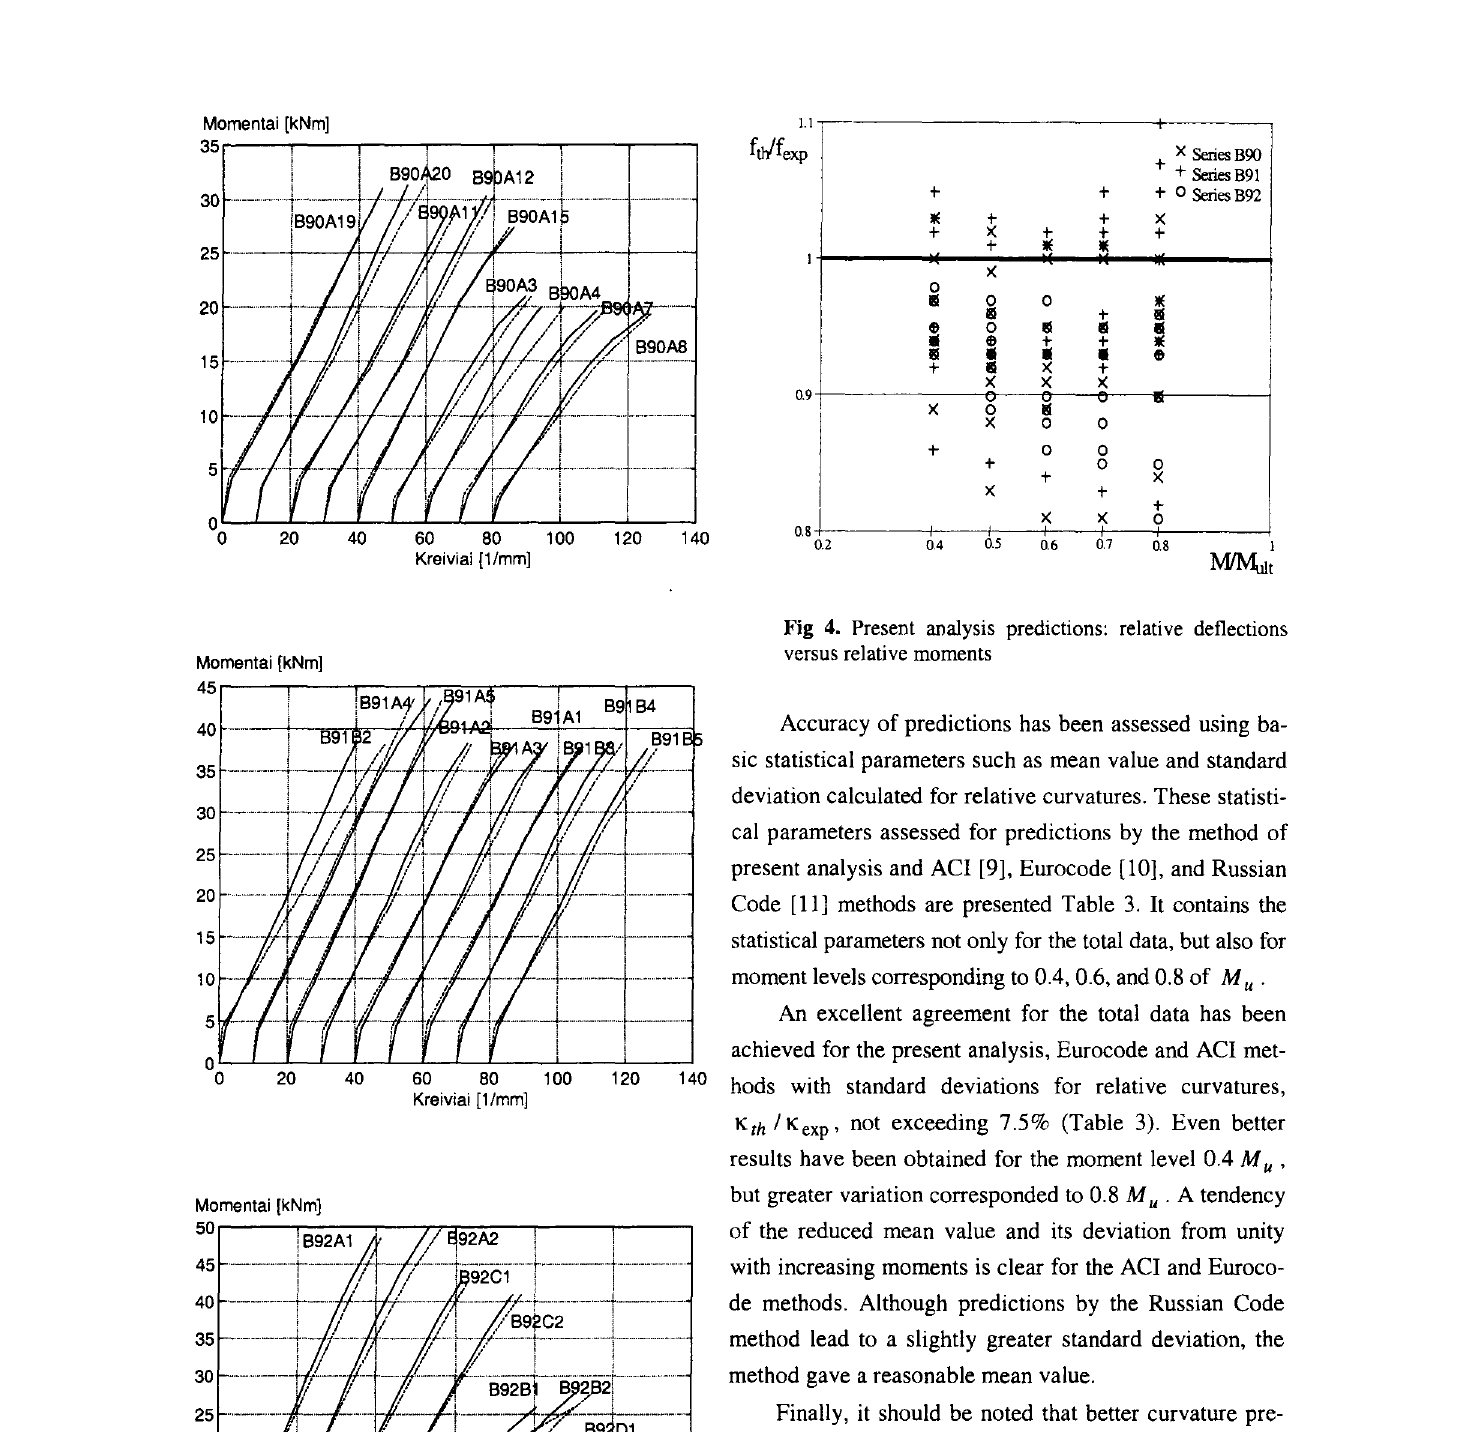
Fig 3. Moment-curvature diagrams ____ - com- puter, --------- - experimental